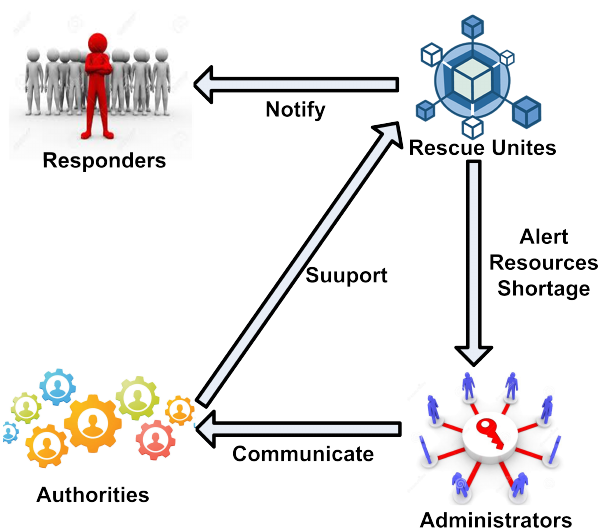
Figure 5. Real-time macro crisis response